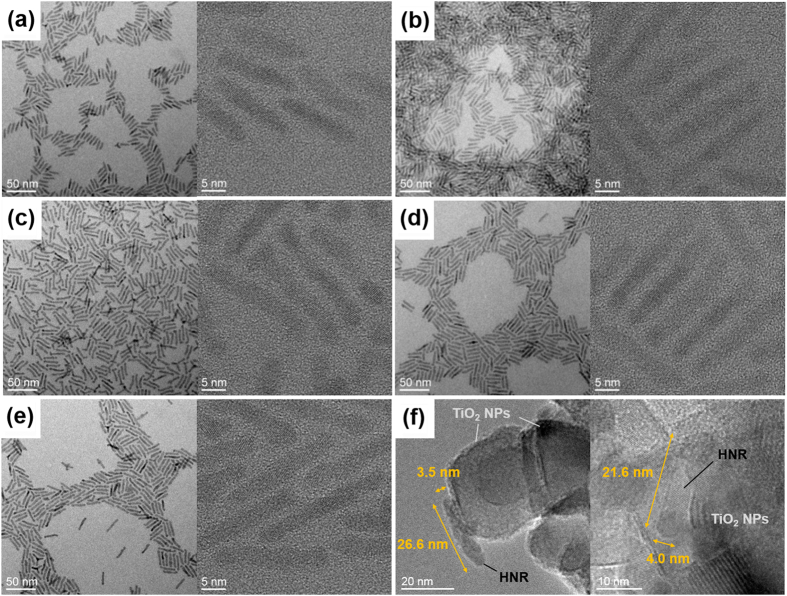
Transmission electron micrographs of (a) the seed CdSe NRs, (b) TOPO-CdSe NRs, (c) TOPO-CdSe/CdTe HNRs, (d) TOPO-CdSe/CdSe0.4Te0.6 HNRs, (e) OT-CdSe/CdSe0.4Te0.6 HNRs, and (f) OT-CdSe/CdSe0.4Te0.6 HNRs anchored to the TiO2 nanoparticles.